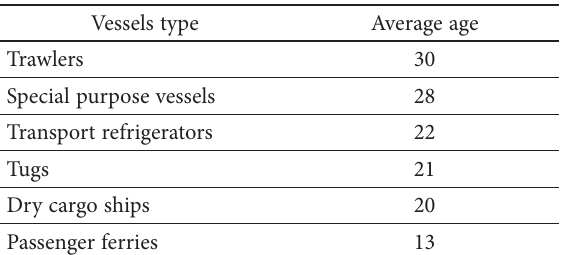
Table 3. The average age of the Lithuanian fleet in 2013